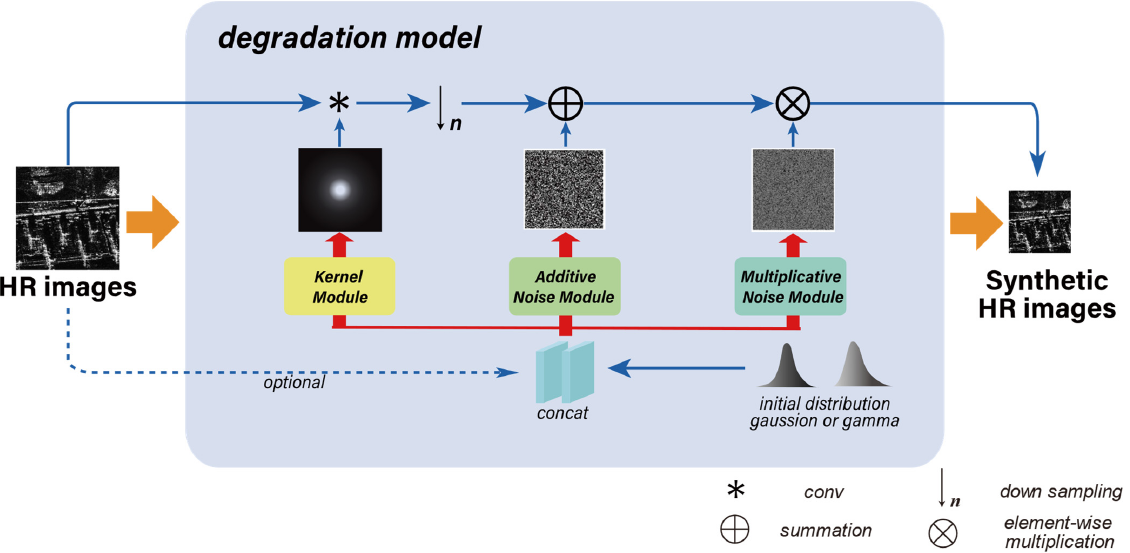
Figure 2. The architecture of the probabilistic degradation model. The PDM model consists of a kernel module, an additive noise module and a multiplicative noise module. These modules are organized in a specific degradation function.